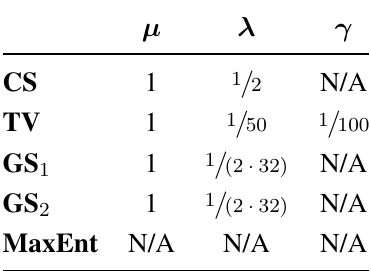
Figure 1. Illustration of the coefficient grouping support of a single data point for equal sized non-overlapping and 50% overlapping groups.